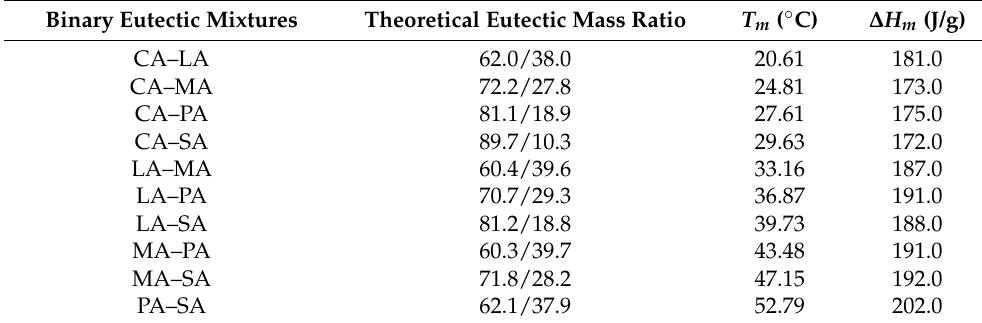
Table 3. Comparison of the eutectic mass ratios of ten binary eutectic mixes between theoretical and experimental